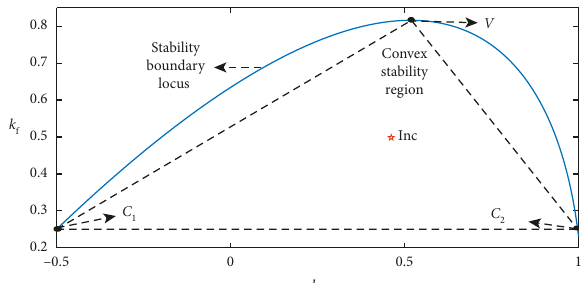
Figure 2: Convex stability region and incenter of PD controller in example